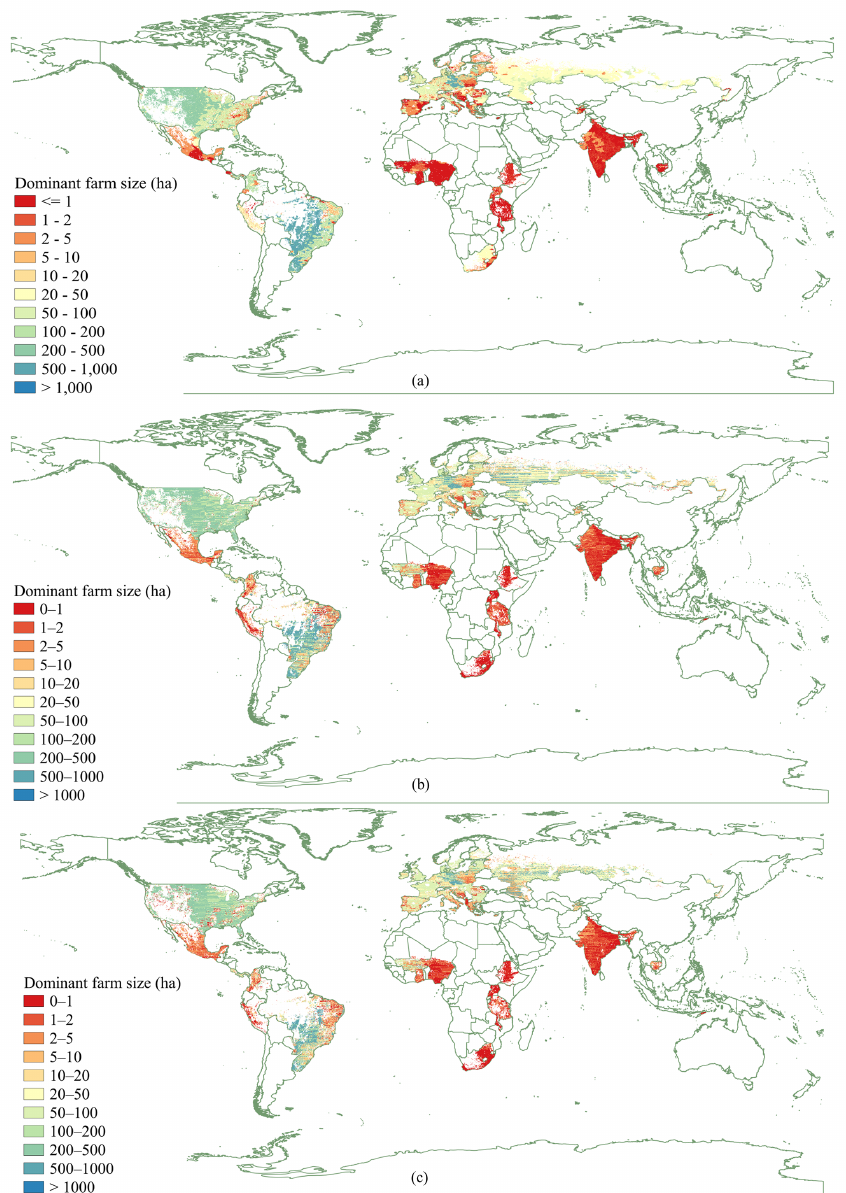
Figure 8. Dominant farm size according to the dataset by Mehrabi et al. (2020) (a) , our farm-size-specific and crop-specific dataset based on the GAEZv4 crop map (b) and SPAM2010 crop map (c) . Only cells included in both the dataset of Mehrabi et al. (2020) and our datasets are